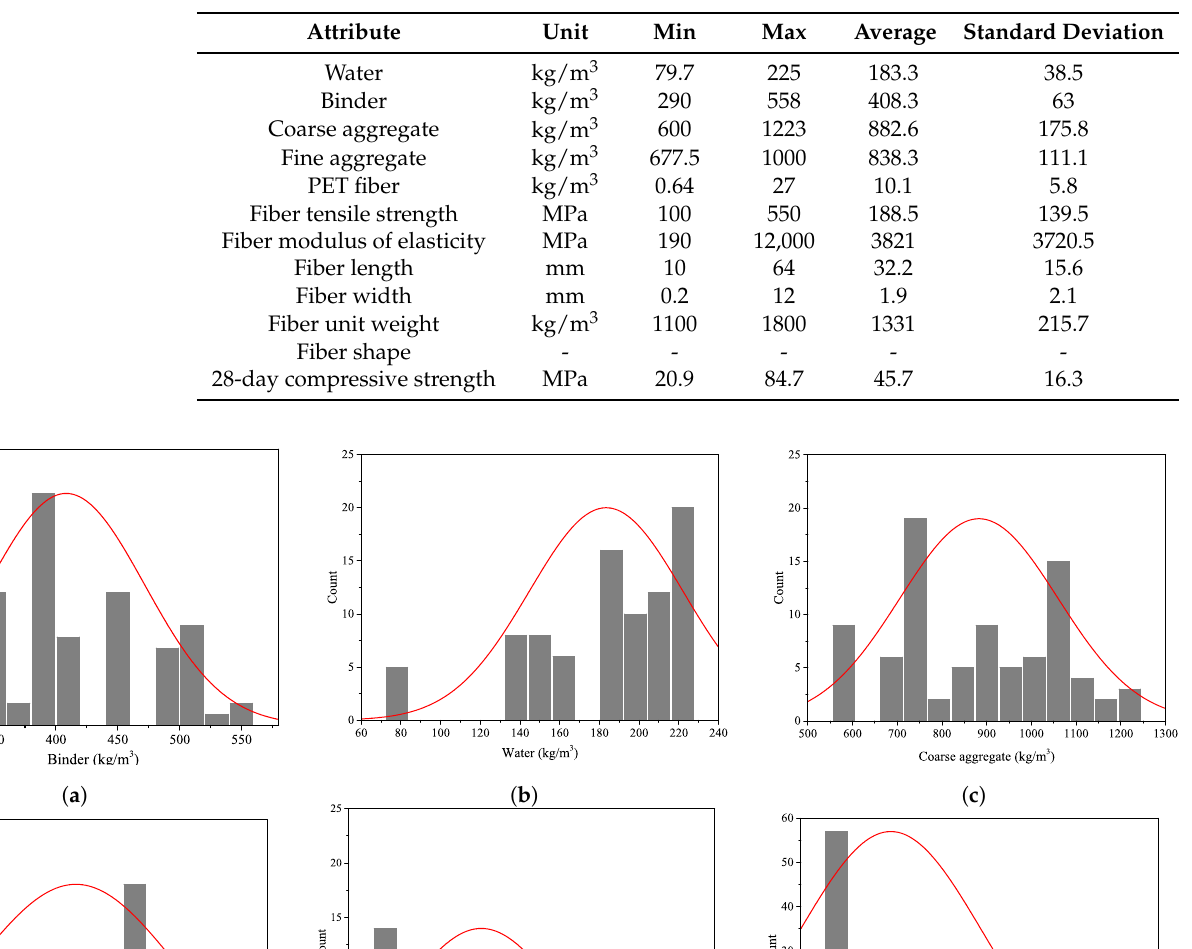
Figure 1. Four different types of PET shape considered in the dataset. Table 1. Statistical parameters for the concrete containing PET fiber dataset.